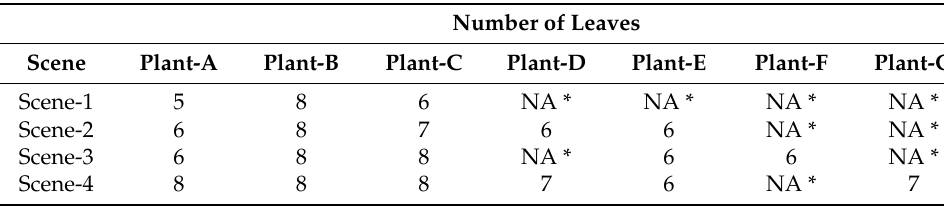
NA * = Plant does not appear in the scene.